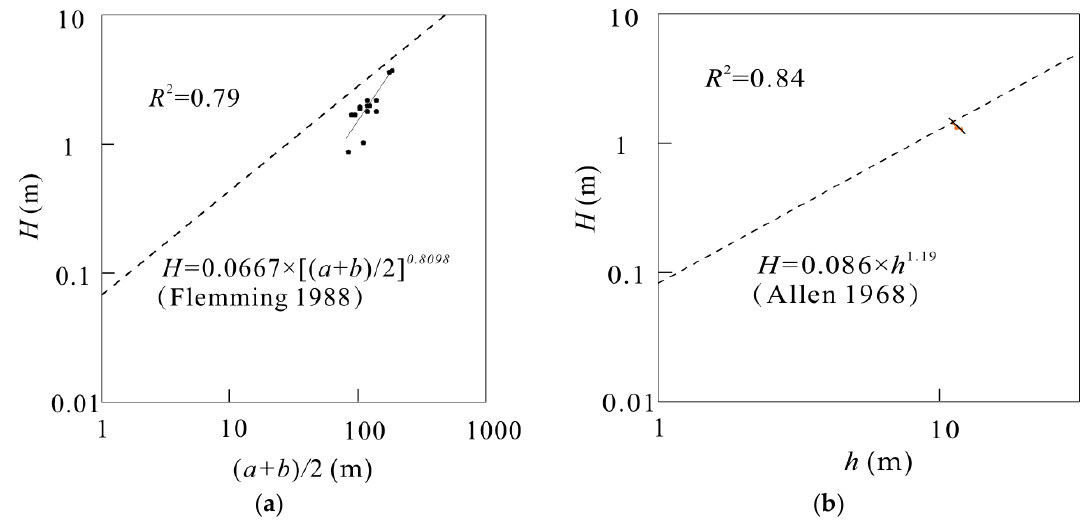
Figure 12. The relationship between mound height H and ( a ) mound width (a + b)/ 2; ( b ) water depth h.